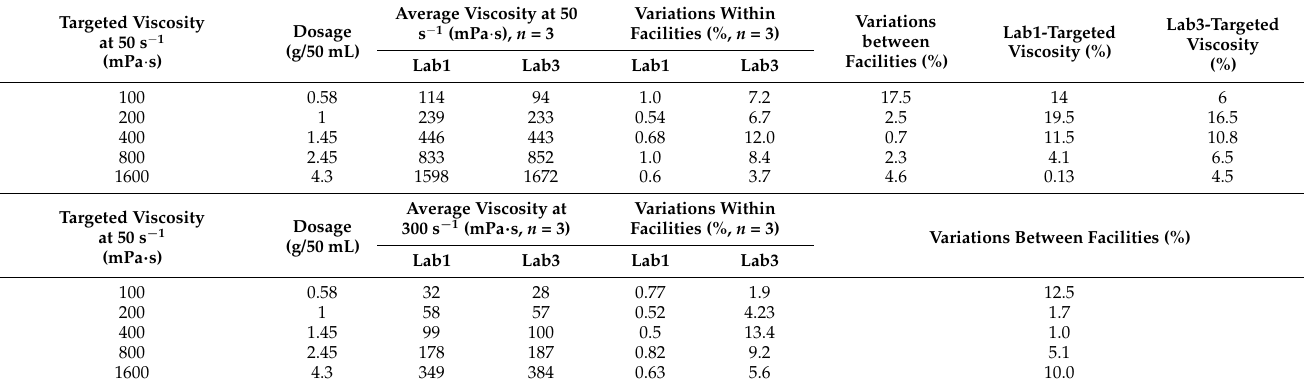
Table 7. Viscosity assessment between Lab1 (reference lab) and Lab3 (Healthcare center for the CT) for the VFS